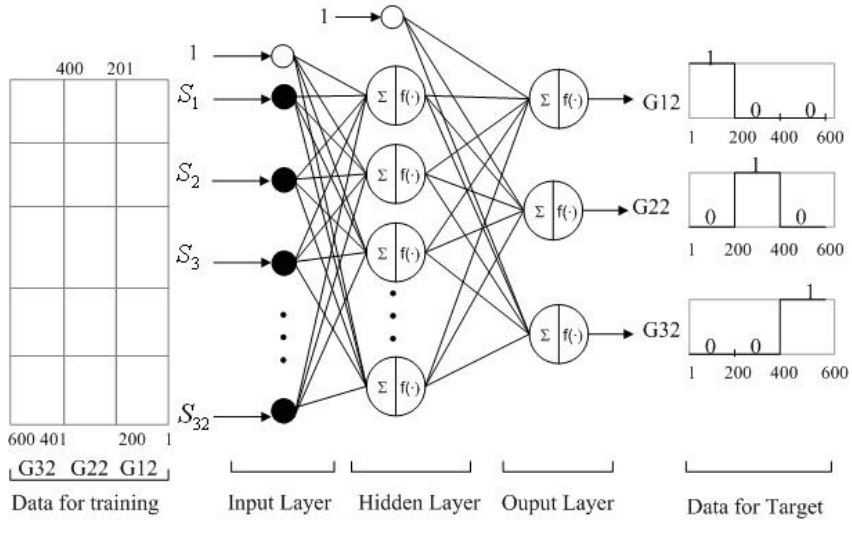
Figure 7. The architecture of three layers ANN with Levenberg-Marquardt algorithm applied for training and identification G12, G22, and G32.